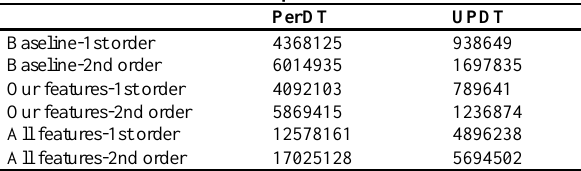
Table 7. Feature Space